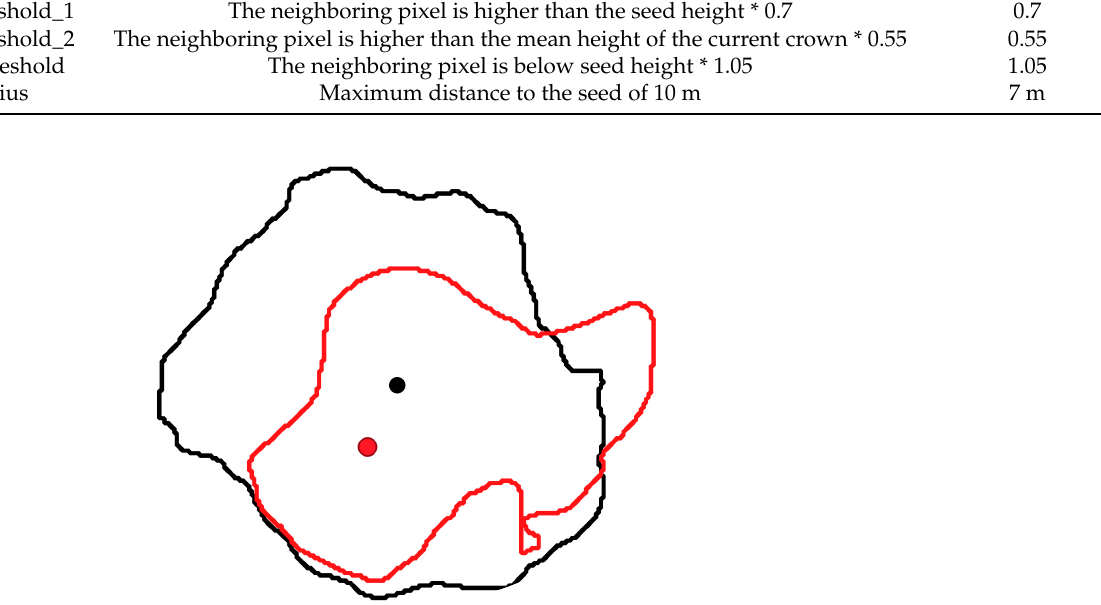
Figure A1. The example of multitemporal matching based on treetop positions. The treetop of the tree in 2014 (in red) is inside the circular area, whose center is defined by the position of the treetop in 2013 (in black) and whose diameter is equal to the diameter of the crown. In this case, the matching algorithm provides a positive outcome.